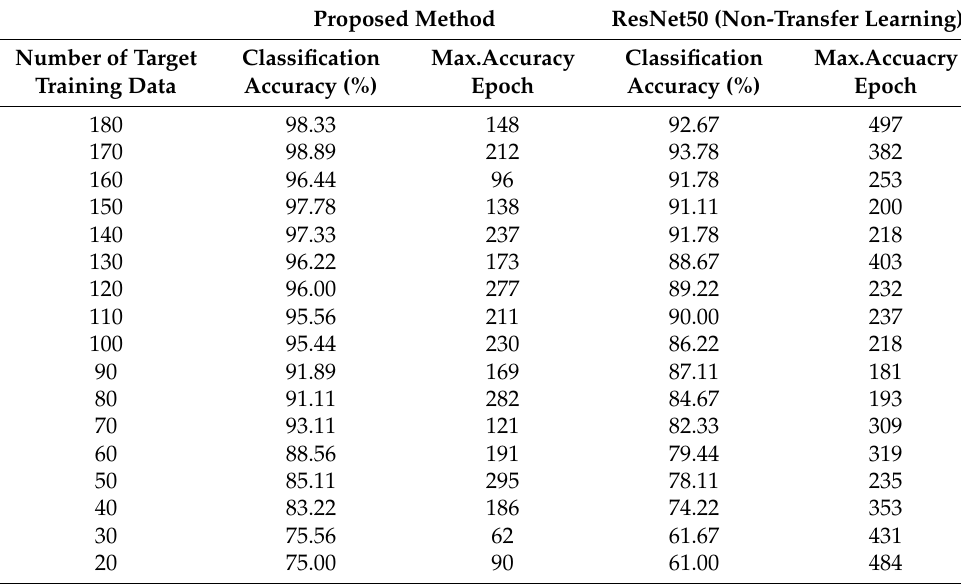
Table 4. Comparison results of the proposed and non-transfer learning